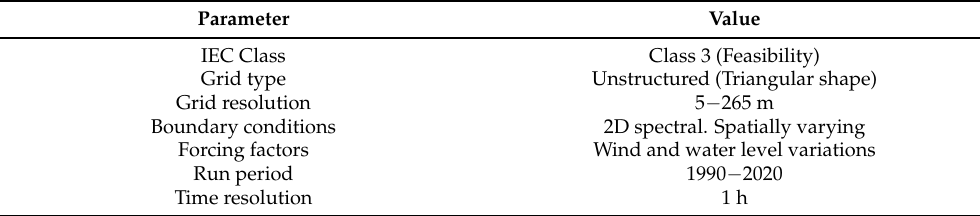
Table A1. Input parameters for the LCoE